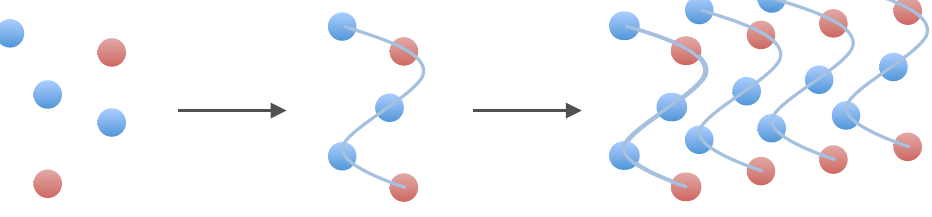
Figure 3. Progression from monomers to polymers to